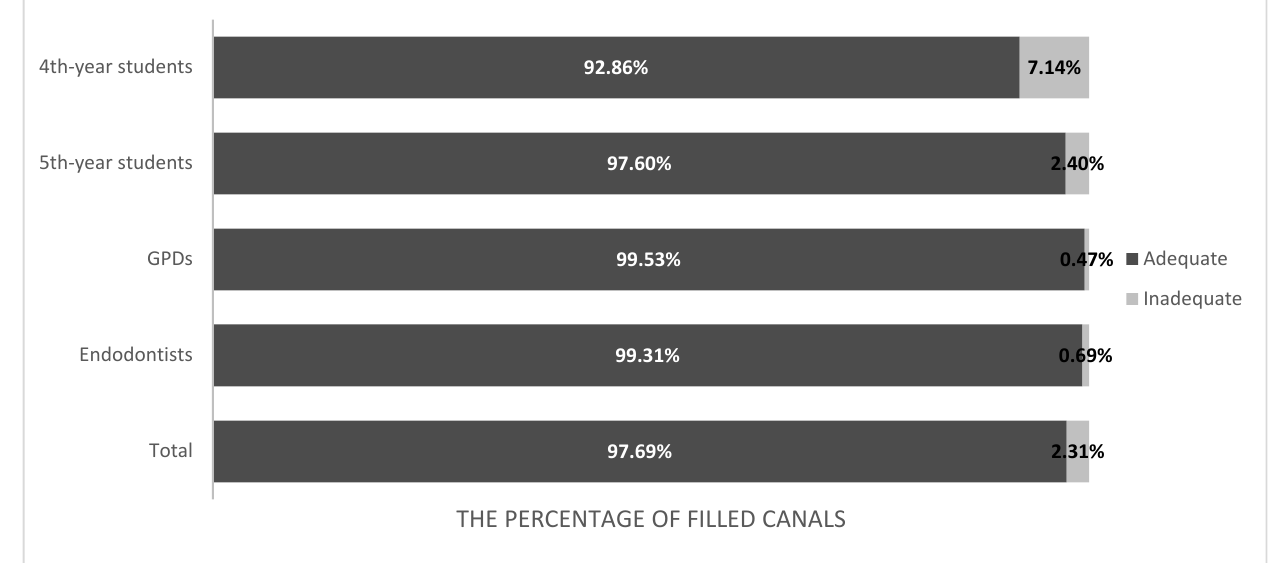
Figure 2. The distribution of density of canal filling in evaluated groups.